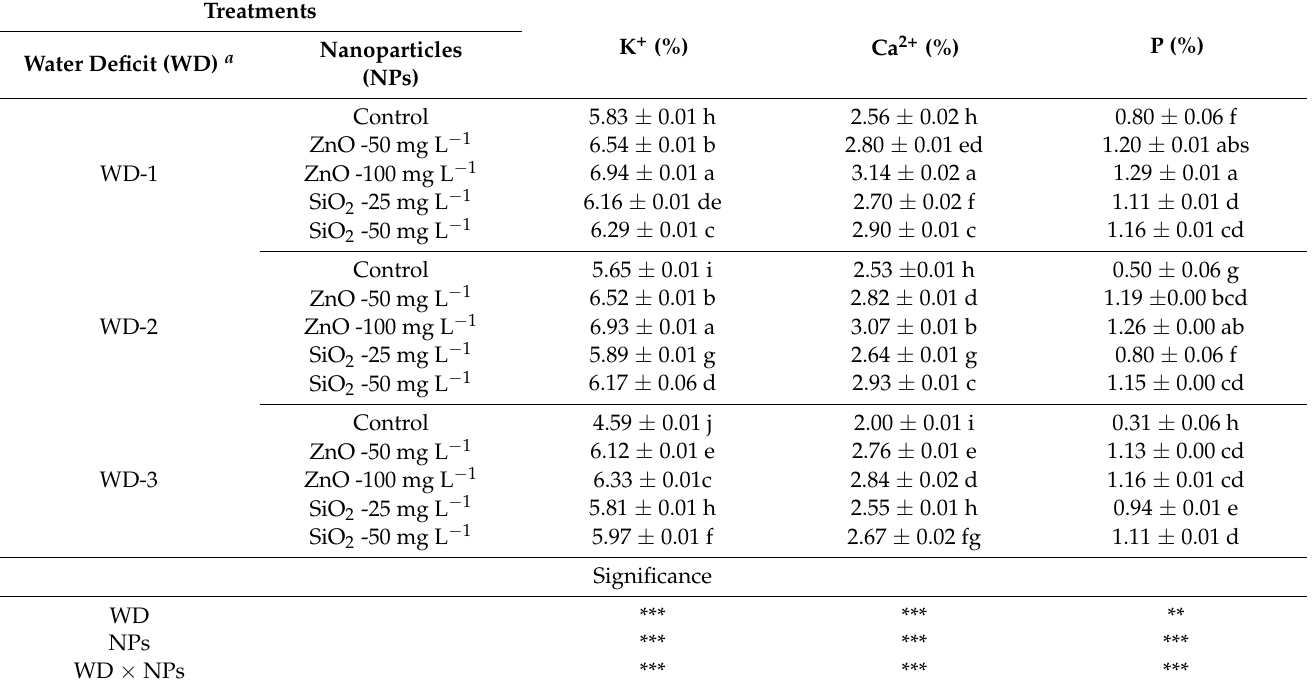
Table 5. Influence of foliar nanoparticles (NPs) on potassium, calcium, and phosphorus percentage in potato tubers grown under different water deficit conditions (irrigation